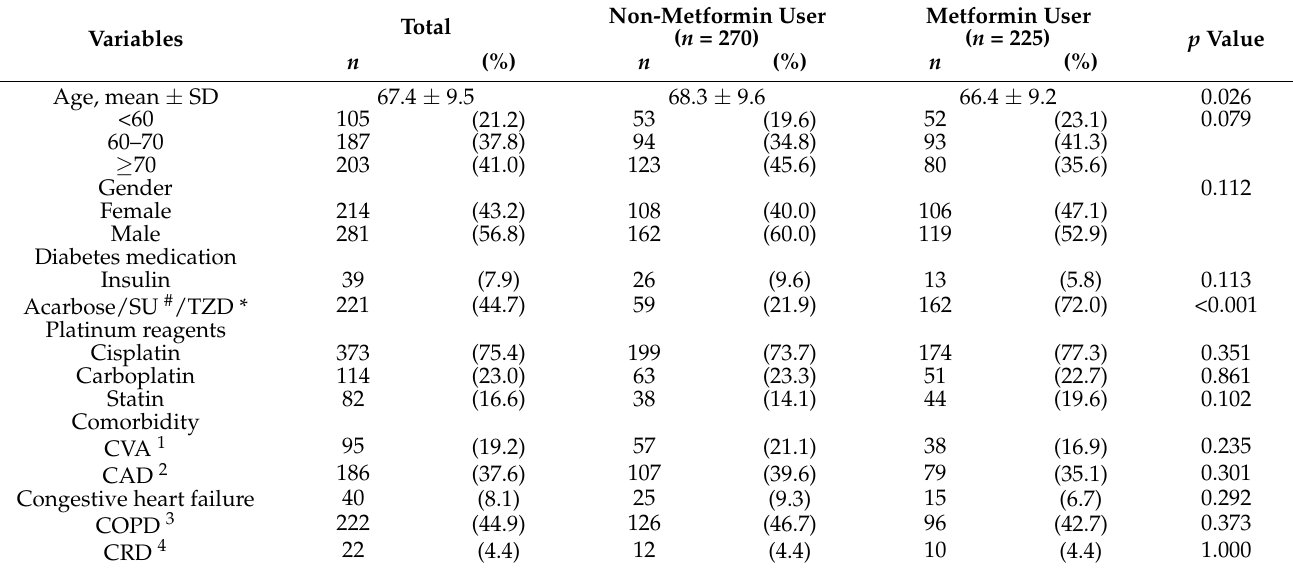
Table 1. Baseline characteristics of study subjects (n = 495).